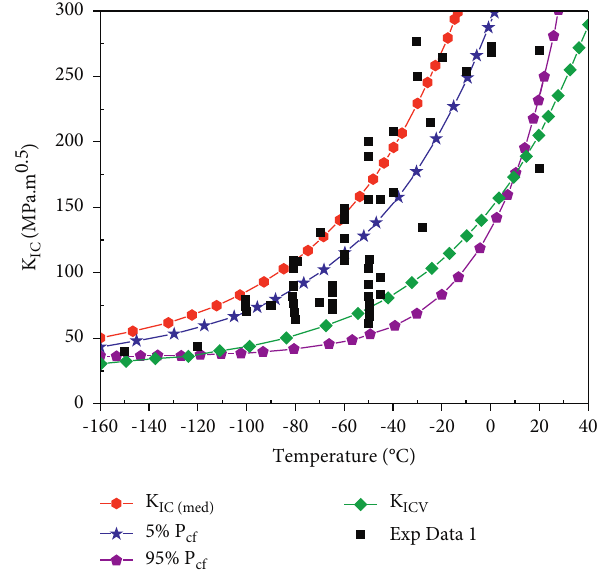
Figure 16: Fracture toughness curve generated by MC approach using fracture toughness Exp Data 1, T 0 �− 64.3 ° C, and 5% and 95% RPV material failure probability.